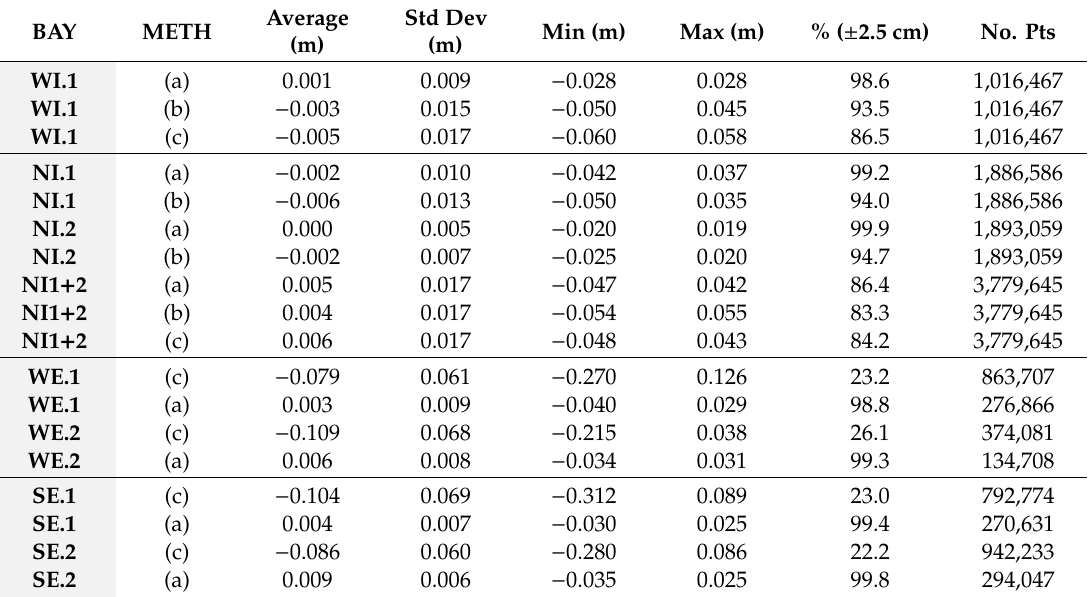
Table 1. Reference planes statistics of distance points-plane